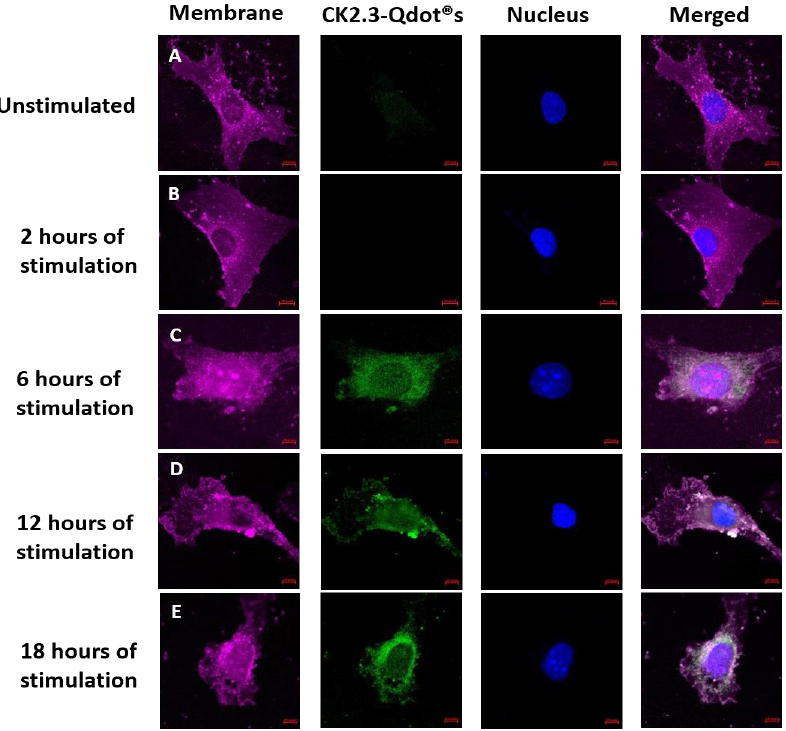
Figure 6. Stimulation of C2C12 cells with CK2.3-Qdot® s (green) for 2 h, 6 h, 12 h, and 18 h. Following stimulation, cells were fixed using 4.4% PFA and the plasma membrane (magenta) and nucleus